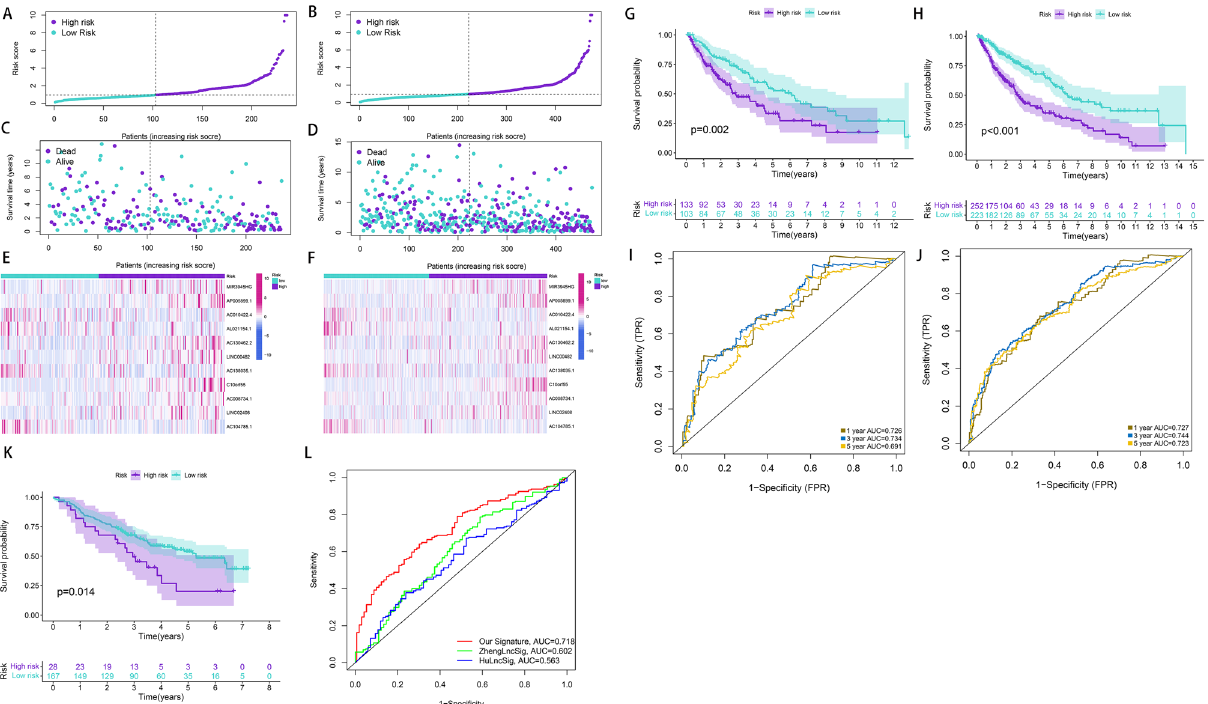
Figure 4. Prognostic analysis of signature in the validation cohorts. ( A,B ) The distribution of risk scores in the TCGA validation set and entire set. ( C,D ) Patient distribution of survival status in the high-risk and low-risk groups in the TCGA validation set and entire set. ( E,F ) The heatmap showing expression profiles of the 11 pyroptosis-related lncRNAs in the TCGA validation set and entire TCGA set. ( G,H ) Survival analysis in the high-risk and low-risk groups for the TCGA validation set and entire set. ( I,J ) ROC curve for 1, 3, and 5 year OS predictions based on the signature the TCGA validation set and entire set. ( K ) Kaplan–Meier analysis of high-risk and low-risk patients for GSE81089 set. ( L ) ROC curves for 5 year OS predictions by our signature and previously reported signatures. TCGA The Cancer Genome Atlas, lncRNA long non-coding RNAs, ROC receiver operating characteristic, OS overall survival.